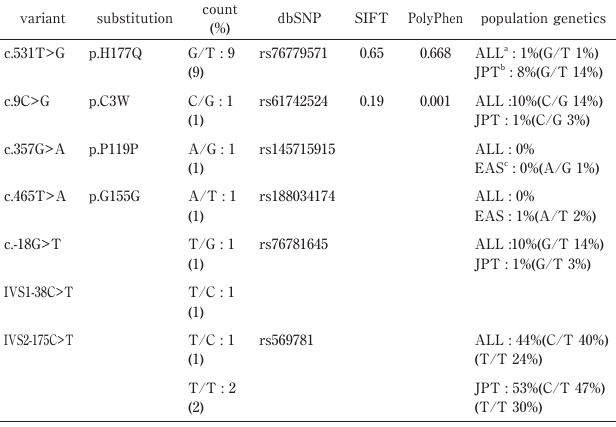
Table 1. Variations found in the JUNO gene among the study